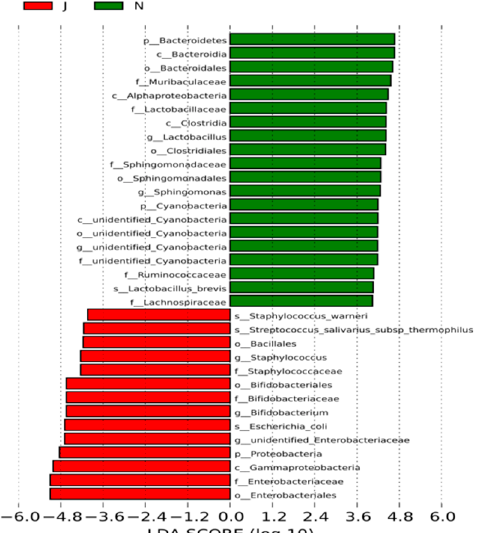
Figure 3. Fecal microbiota compositions differed significantly in neonates with jaundice. Green represents the healthy controls; red represents the jaundice group. p, c, o, f, g, and s represent phylum, class, order, family, genus, and species, respectively. The dominant microbes of the neonatal jaundice group differed significantly from those of healthy controls at all levels.